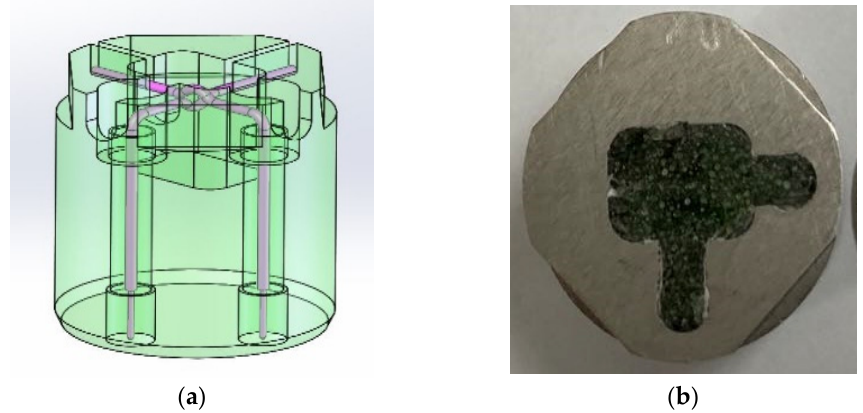
Figure 10. Antenna design and development image: ( a ) 3D design drawing; ( b ) actual development image diagram of antenna.